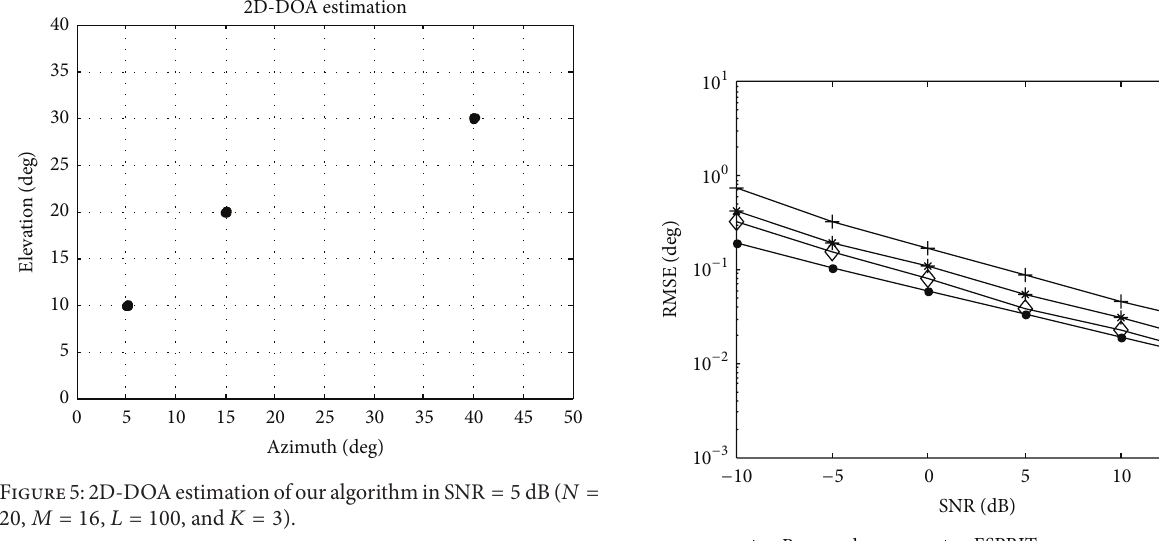
Figure 6: 2D-DOA estimation performance comparison ( 𝑁 = 20 , 𝑀 = 16 , 𝐿 = 100 , and 𝐾 = 3 ).